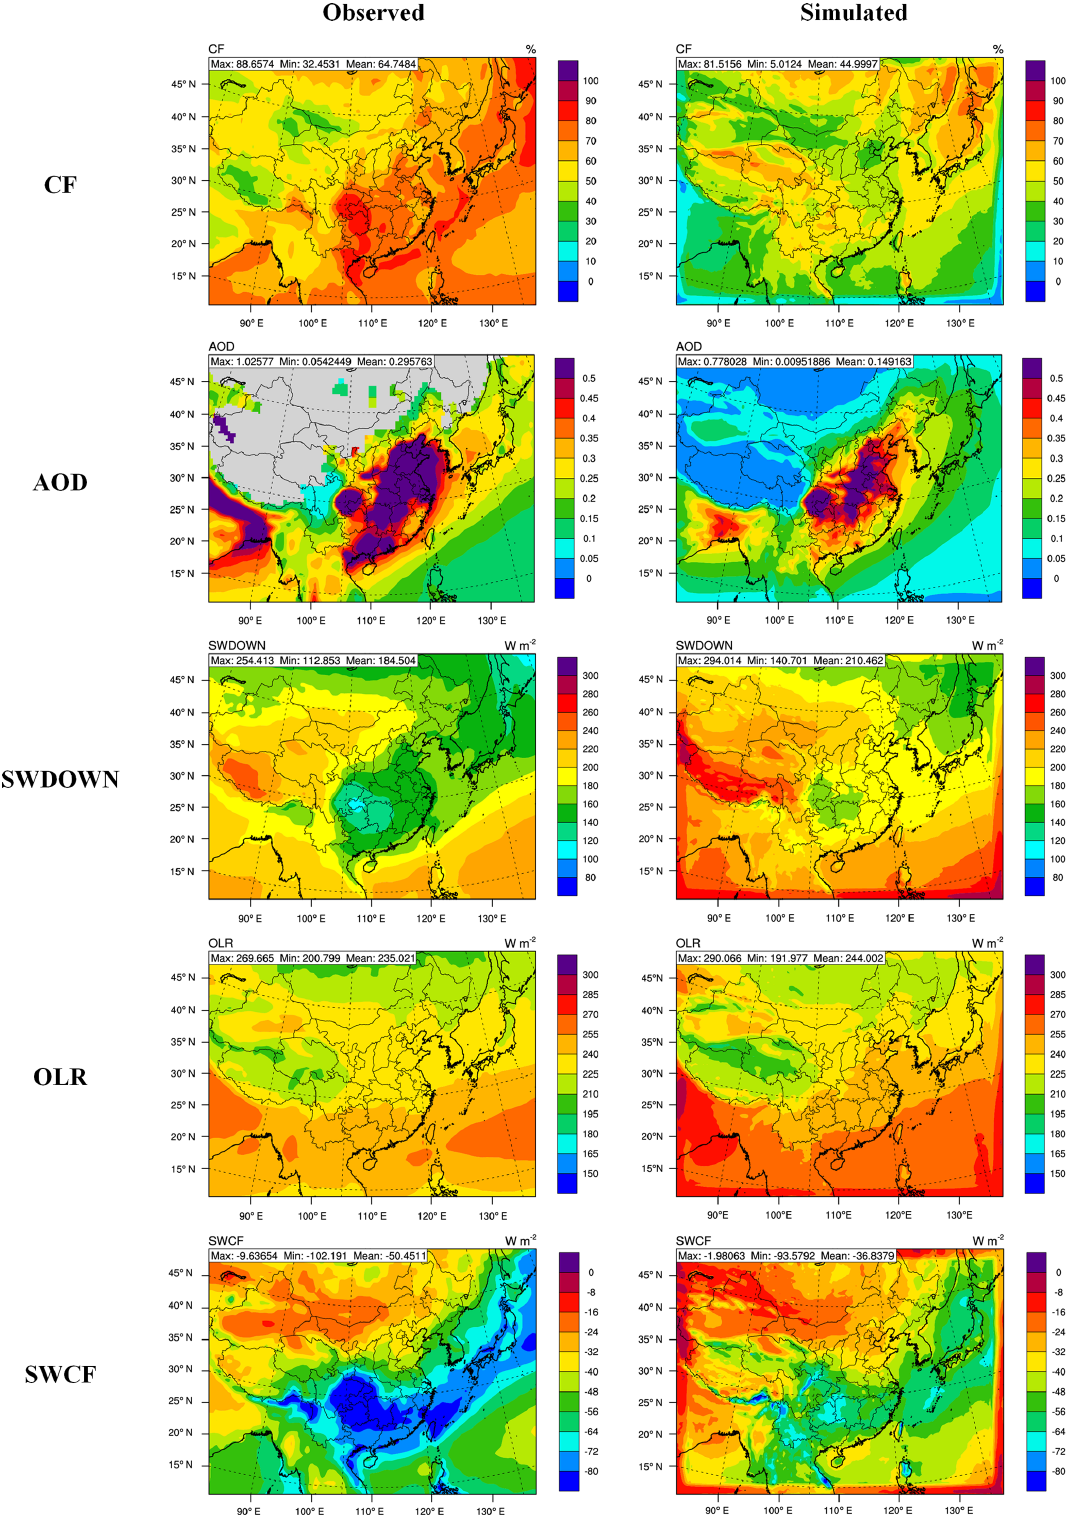
Figure 5. Spatial distribution of satellite-derived and simulated multi-year means of CF, AOD, SWDOWN, OLR, and SWCF under the climatological application for the time period